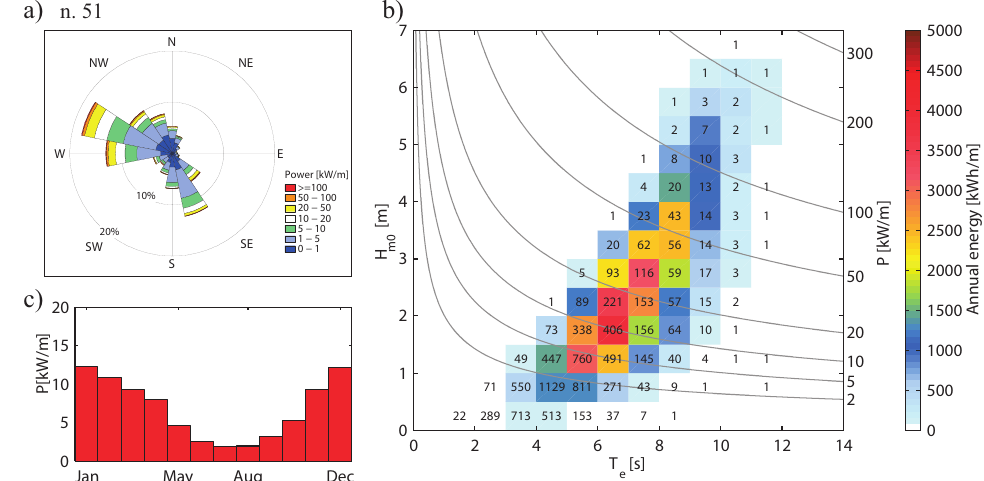
Figure 7. Characterisation of mean yearly wave energy and wave energy flux climate at point n.51; in ( a ), the wave energy flux rose; ( b ) the scatter plot of H m e T e , the colour scale indicates annual 0 energy per meter of wave front (kWh/m), the numbers within the bins indicate the occurrence of sea states (hours/year) and the isolines specify the wave energy flux; ( c ) the histograms of the monthly mean wave energy